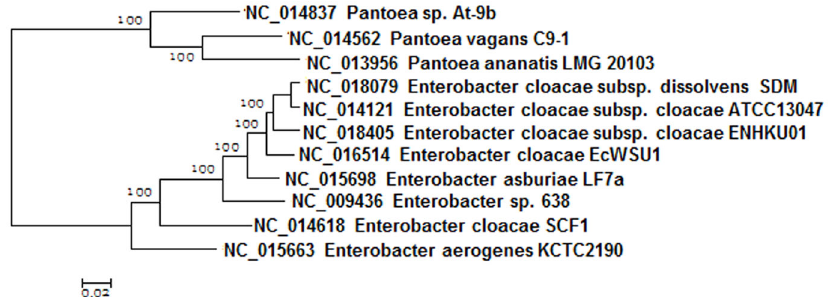
Figure 1. Phylogenomic analysis of Enterobacter spp. Bayesian tree with posterior p-values of the genomes of Enterobacter spp. using 1732 core genes of eight Enterobacter and three Pantoea genomes. doi: